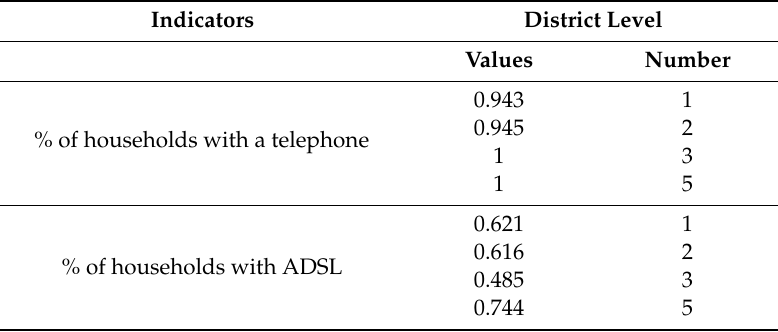
Table 7. Values of communication indicators calculated at the census section level but presented in this table at the district level because their values are quite homogeneous in the study